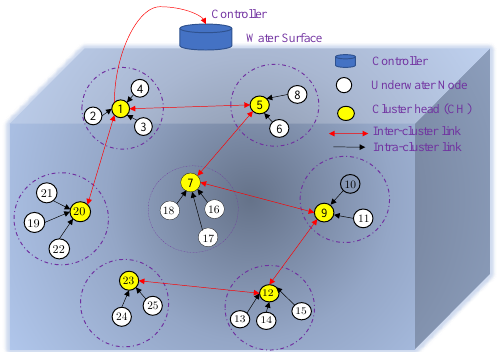
Figure 3. The FL-SDUAN routing schematic.